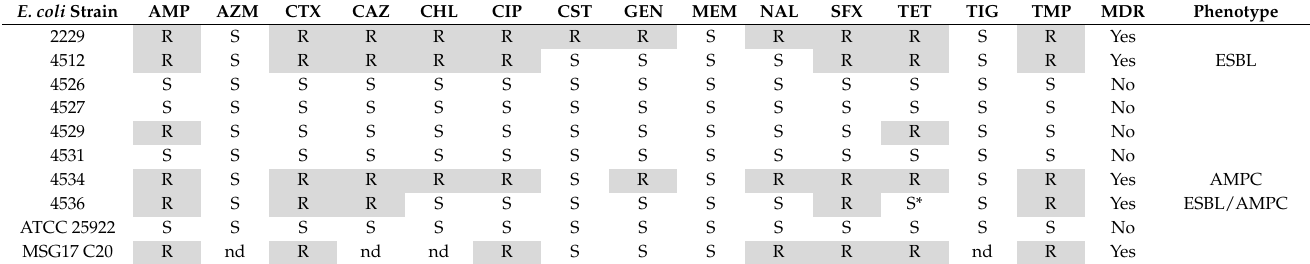
Table 1. Antimicrobial resistances of the Escherichia coli strains selected for the